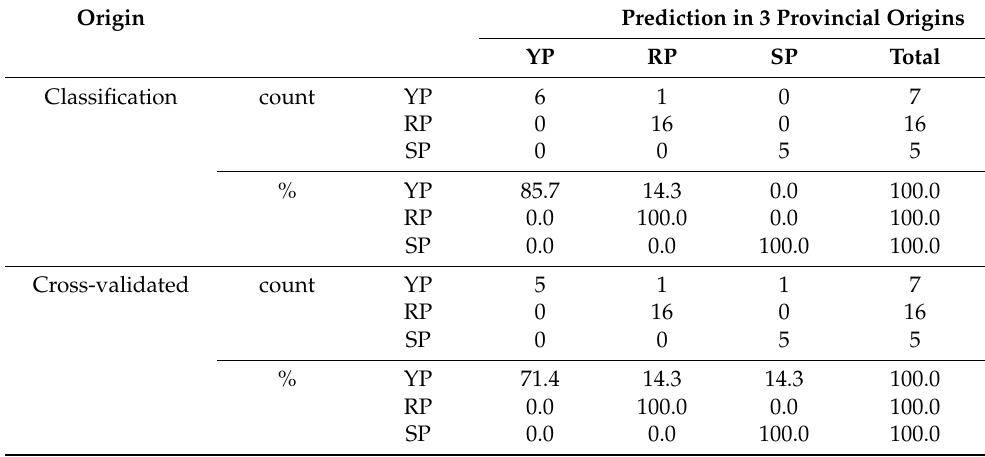
Table 3. LDA with correct classification and cross-validation of THMR in three contiguous provinces of origins using elemental and isotopic